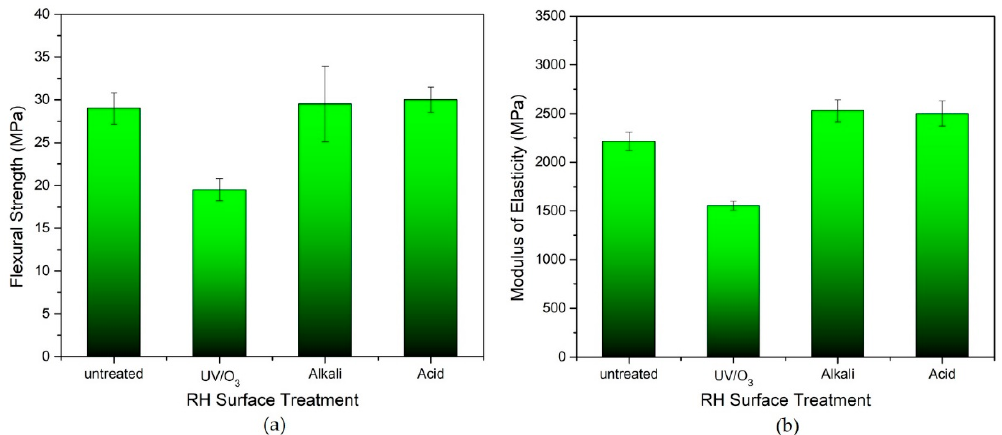
Figure 4. ( a ) Flexural strength and ( b ) modulus of elasticity of untreated RH, UV-, alkali- and acid-treated RH with 50 wt.% RH loading.